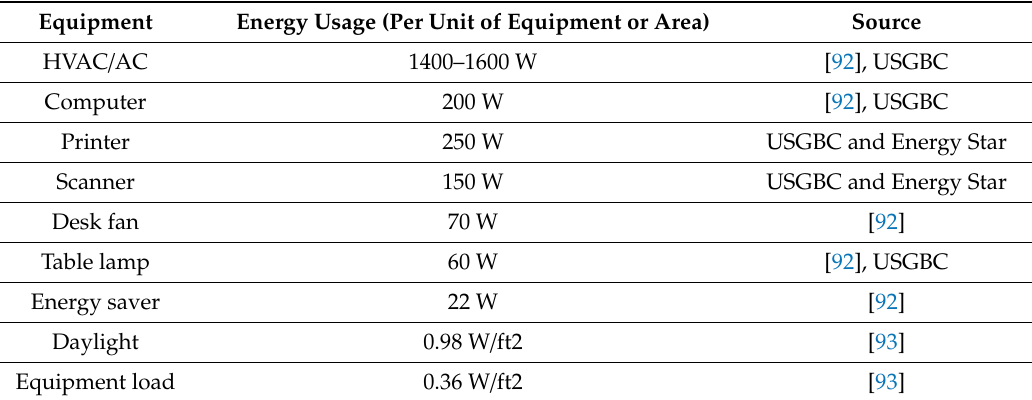
Table 5. Equipment standard energy usage